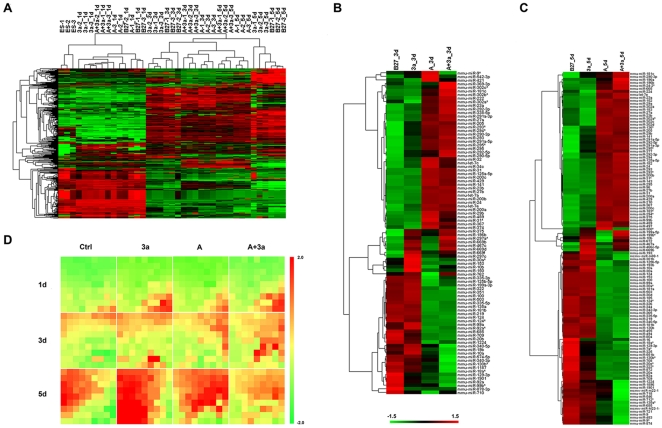
Differentially expressed miRNAs during DE differentiation from mouse ESCs.Mouse ESCs were treated with 100 ng/ml Activin A, 50 ng/ml Wnt3a, or 100 ng/ml plus 50 ng/ml Wnt3a, and the samples were collected and profiled for miRNA expression at 1 day, 3 days, and 5 days after treatment. The differentially expressed miRNAs were identified by using ANOVA test under FDR <0.05. A. 386 differentially expressed miRNAs in all samples were presented using hierarchal clustering analysis. The miRNAs expression values were normalized by Z-score normalization, and the hierarchal clustering was performed in Cluster3.0 using average linkage with Euclidean being used as the distance metrics. B, C. Hierarchal clustering of 90 and 118 differentially expressed miRNAs under the cutoff as FDR <0.05 and fold>2 or <0.5 in 3 day and 5 day samples, respectively. D. 386 differentially expressed miRNAs identified by ANOVA were analyzed in Genespring using 9×9 SOM methods with Euclidean being used as the distance metrics. Heatmap presented average expression pattern of the miRNAs in each cluster from SOM in different treatment groups. The position of each cluster was presented as Cluster (Cij), i means row; j means column. For example, C32 means the cluster at the third row and second column. Please note the distinct expression fingerprint of miRNAs during DE differentiation. The differentially expressed miRNAs for each time point were listed in Table S2, S3, and S4, respectively. A: Activin A; 3a:Wnt3a.